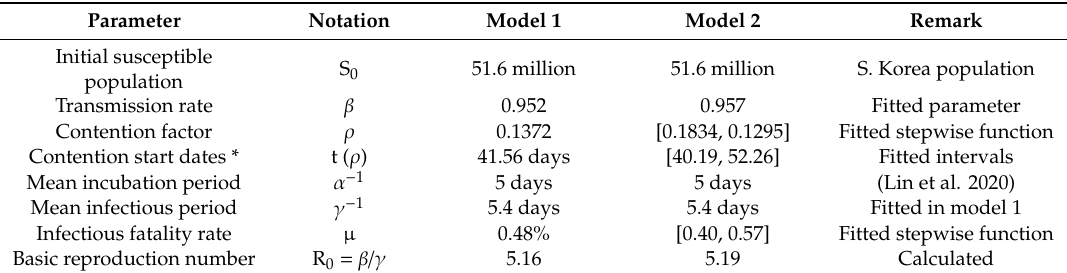
Table 2. Model 1 corresponds to a one change point scenario, and model 2 to a two change points scenario. To each change point corresponds a contention factor and a contention date, representing the intensity and the timing of each change, (*) days after 22 January 2020.